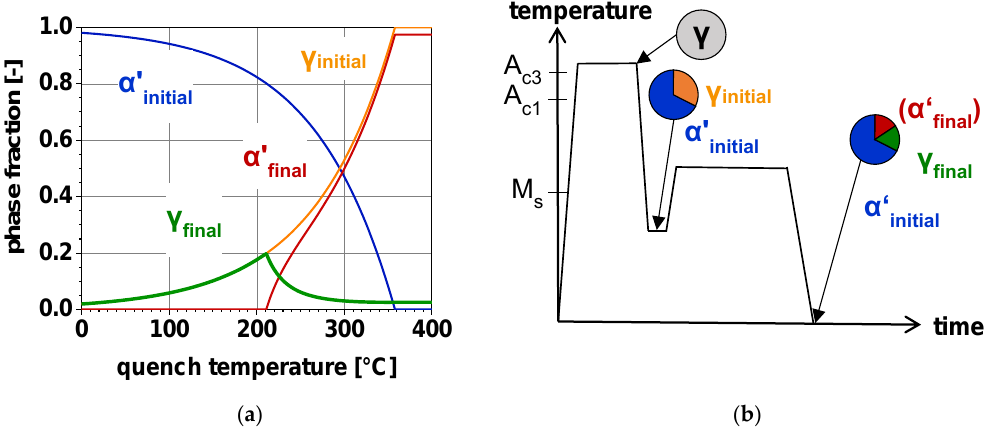
Figure 2. ( a ) Calculated phase fractions of martensite (α’) and austenite (γ) depending on the T Q and ( b ) the related Q&P heat-treatment with the schematic microstructural evolution; the phase fractions are indicated for the initial quench to T Q and for the final quench to room temperature (RT).